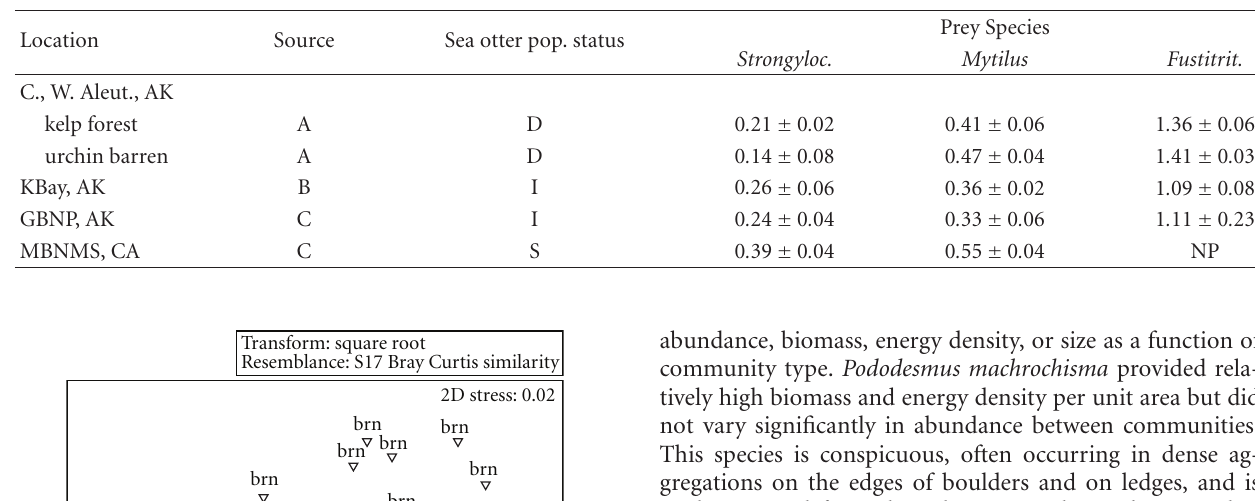
Table 2: Individual prey quality values from remnant kelp forest and urchin barrens sampled in this study and from locations elsewhere in the sea otters range. Values indicate the potential energy density per individual species (kcal · g − 1 wet mass) ± 1 S.D. Prey species in- clude Strongylocentrotus polyacanthus , Mytilus trossulus , and Fusitriton oregonensis . S. polyacanthus is most common in the Aleutians but is compared to S. droebachiensis from other regions in this table given their similarity in mitochondrial DNA analysis [78]. Current population trends were referenced in Estes et al. 2005 [17] (C. and W. Aleut., AK: central and western Aleutians, AK), Gill et al. 2009 [75] (KBay, AK: Kachemak Bay, AK), Bodkin et al. 2003 [76] (GBNP, AK; Glacier Bay, AK), Estes et al. 2003 [21] (MBNMS, CA: Monterey Bay, CA), and Tinker et al. 2008 [77] (SNI, CA: San Nicholas Is., CA). Sources of regional prey values are (A) this study; (B) Stewart and Konar, unpublished data; and (C) Oftedal et al. 2007. Sea otter population status from each location is either (D) declining, (I) increasing, or (S) stable. NP: Not present.